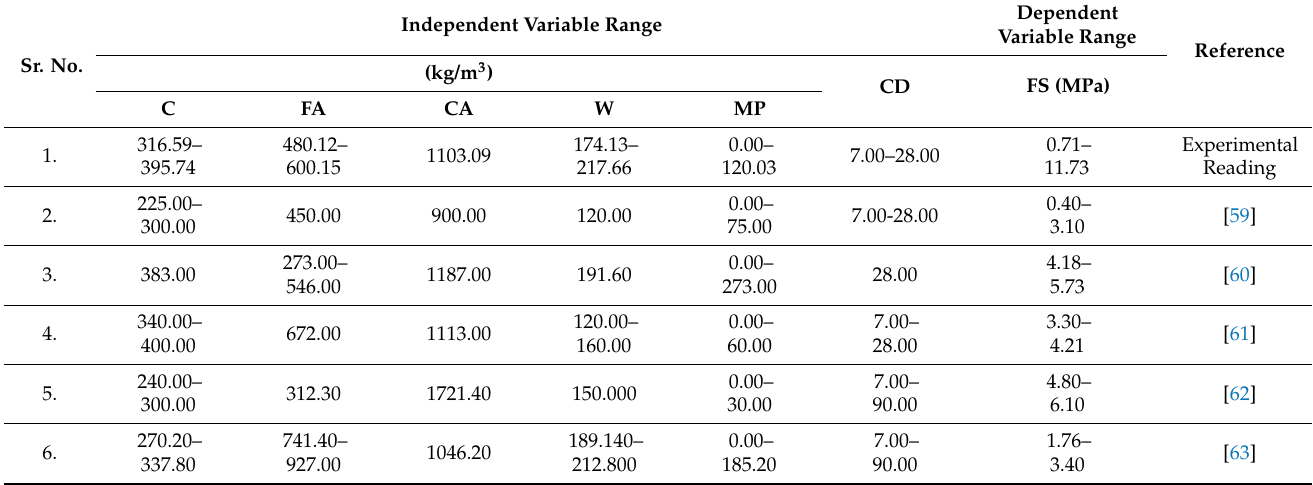
Table 5. Range of the dataset used.